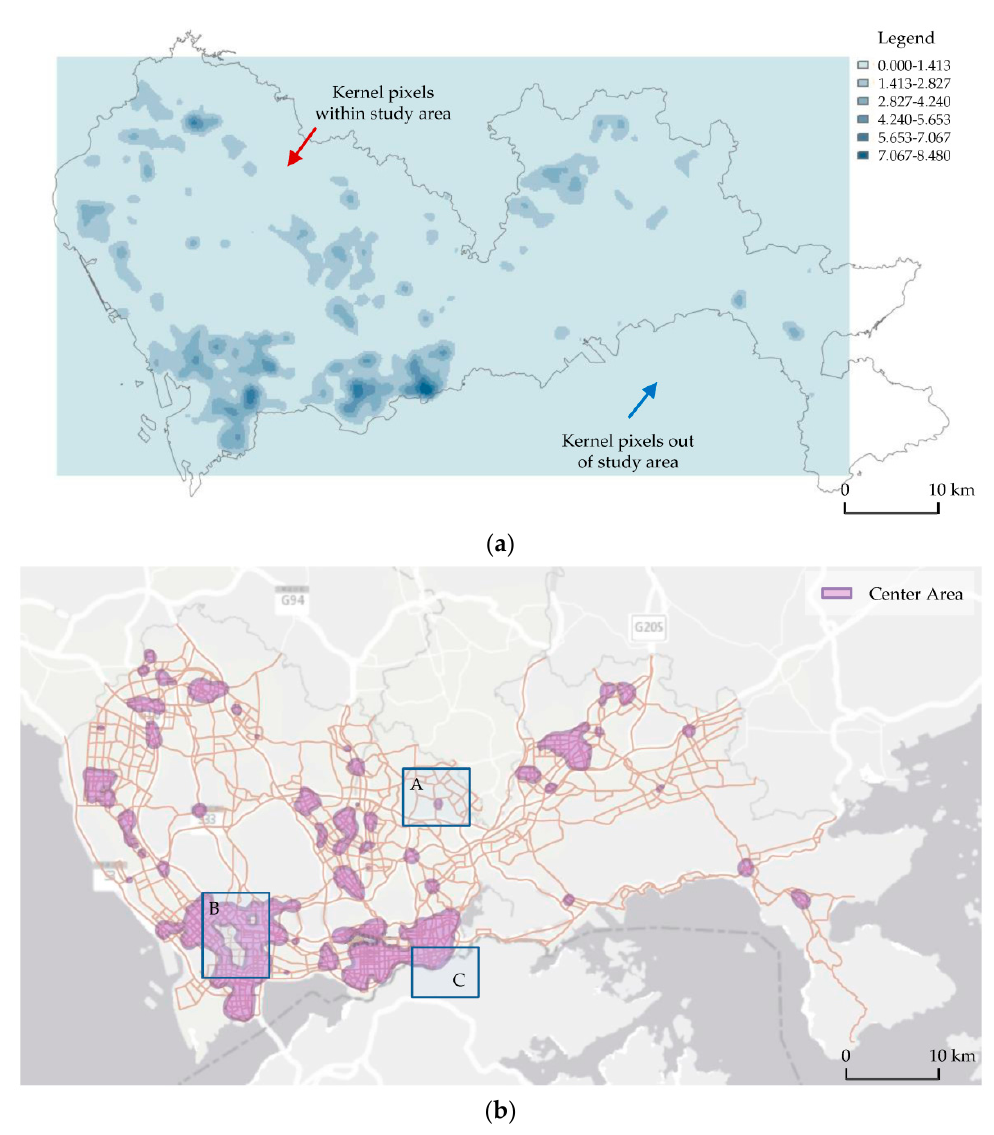
Figure 14. ( a ) Results of kernel density estimation of road nodes in Shenzhen; ( b ) center areas by the contrast method in Shenzhen. Table 1. Characteristics of the recognized results by two methods in two